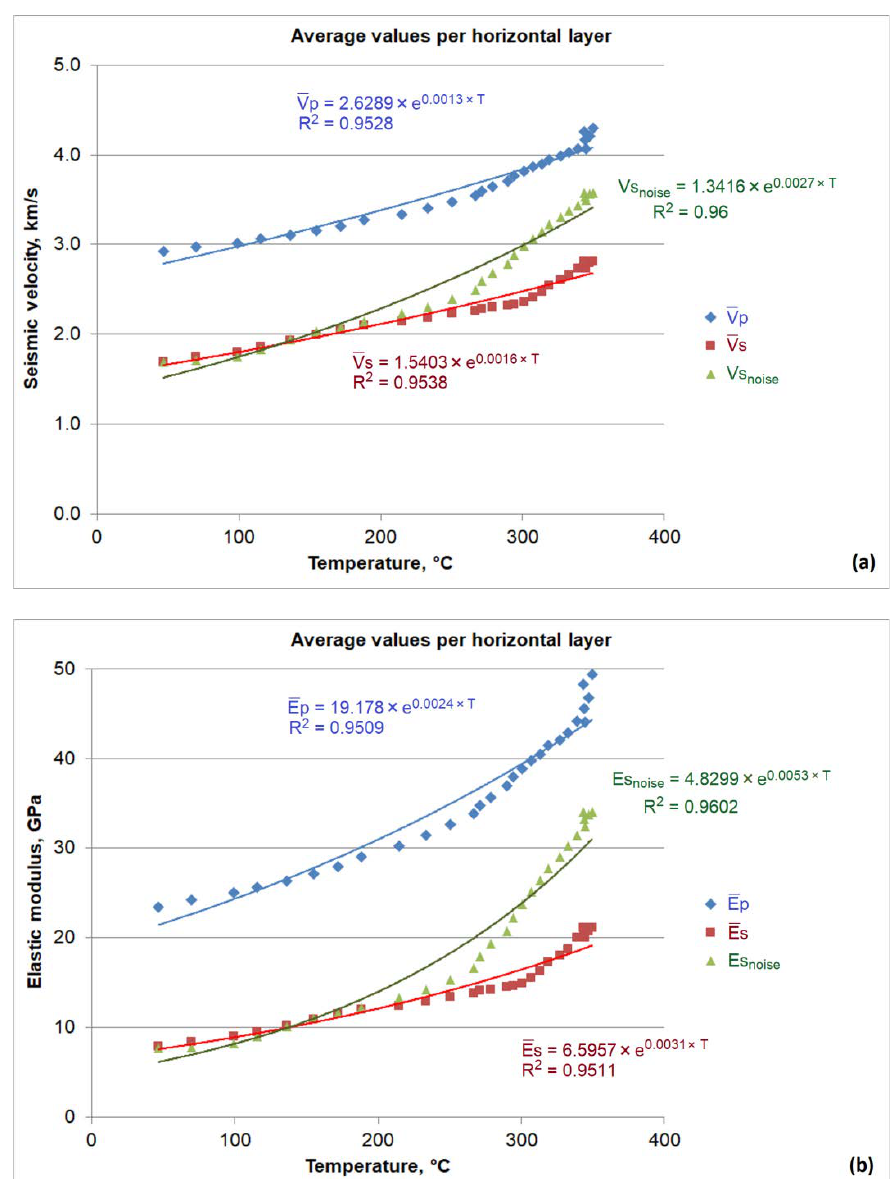
Figure 2. Correlation of 1-D averaged seismic velocities ( a ) and elastic moduli ( b ) in the same elevation above sea level, as derived from the passive seismic survey, with averaged natural state temperatures at the same horizontal elevation layer in Los Humeros.